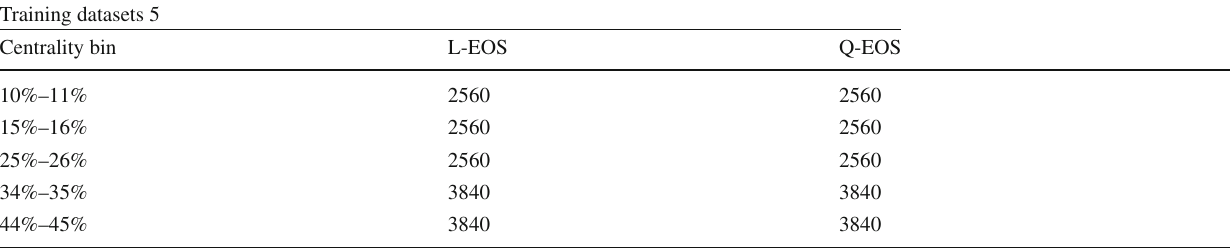
Table 7 Training datasets 5: numbers of event-by-event spectra ρ( p ,(cid:6)) computed by the iEBE-VISHNU hybrid model with the MC- T Glauber initial conditions in the centrality range 0–50%. The ratio